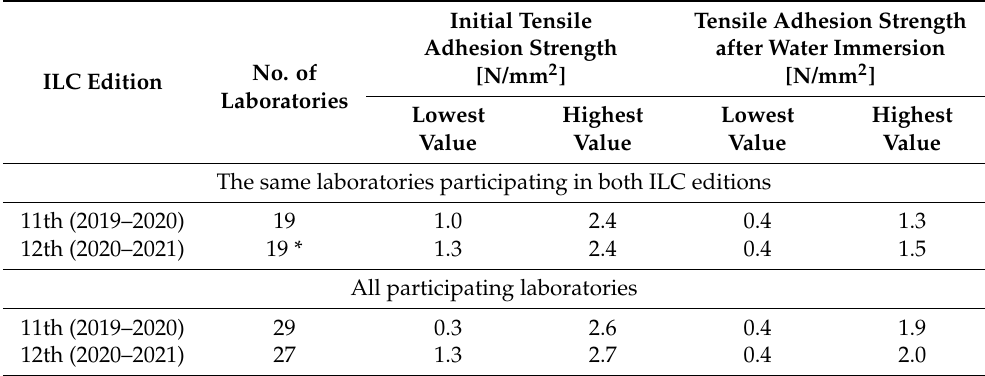
Table 3. The lowest and highest values of the initial tensile adhesion strength and tensile adhesion strength after water immersion of CTA obtained by 19 laboratories and by all participating laboratories in the eleventh and twelfth editions.